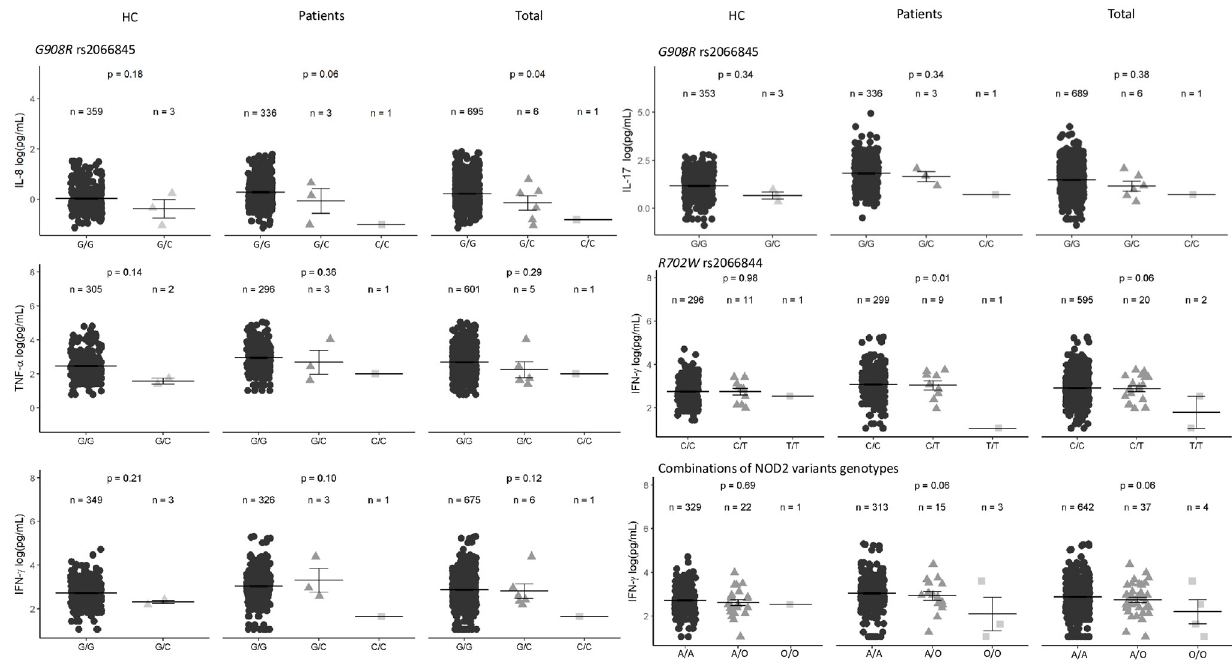
Fig 1. Evaluation of the NOD2 variants genotypes on circulating IL-8, IL-17, IFN- γ , and TNF- α plasma levels in HC, patients with CL, and total (HC + patients with Lg - CL) adjusted for age and sex. The combination for all genotypes, common homozygous (A/A), heterozygous (A/O) and rare homozygous (O/O) are also shown in HC, Patients, and Total (A represent wild-type alleles and O mutant alleles of the three variants). The crossbars (black) represent the mean concentrations in picogram per milliliter log-scale transformed [log(pg/mL)] and the error bars represent the standard error (SE) of means. P values < 0.05 are considered significant. P values were corrected for False Discovery Rates using Benjamini Hochberg procedures.